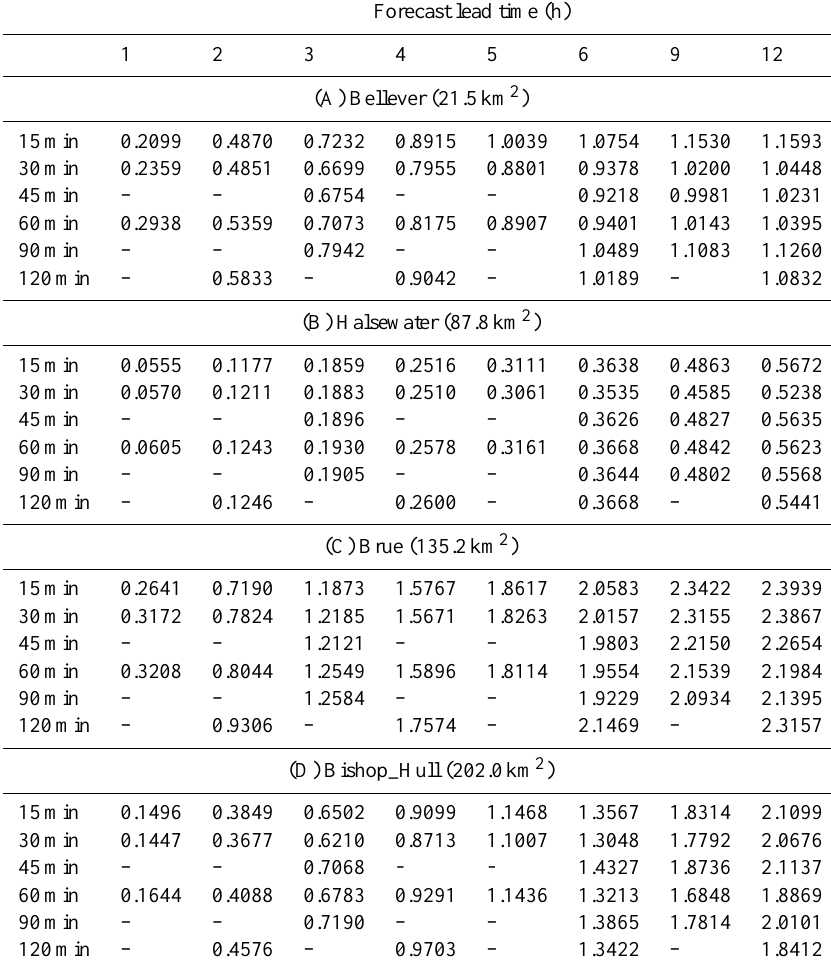
Table 7. Forecasting results shown in RMSE (m 3 s − 1 ) for the four catchments using data with different time intervals. The lowest RMSE value for a certain lead time is highlighted to show the optimal data time